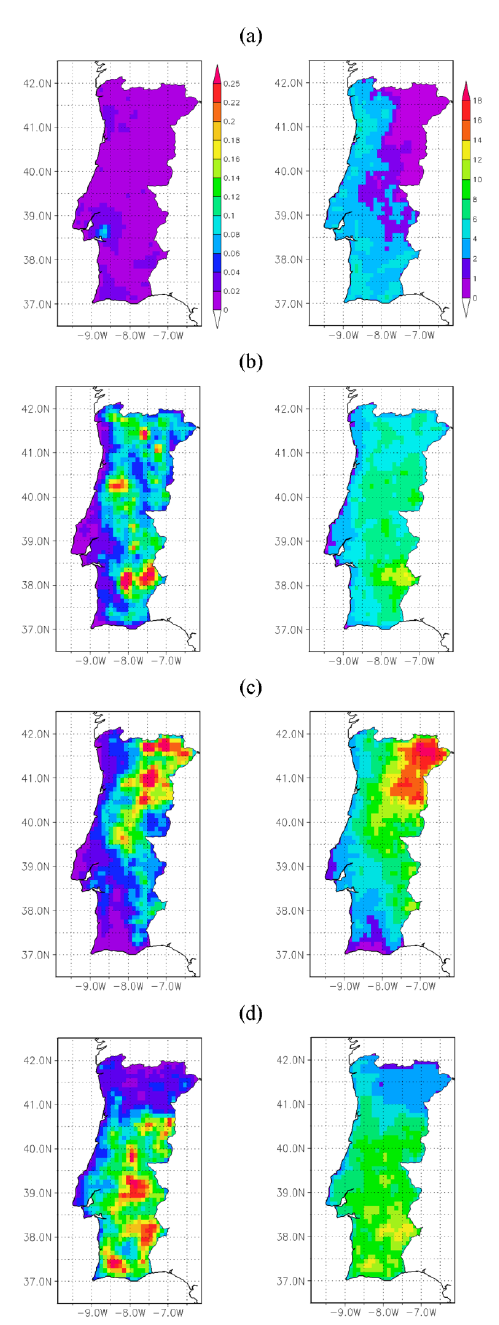
Figure 8. Maps of the KS mean total AEDCGD density ( left panels ; number of 681 Fig. 8. Maps of the KS mean total CGD density (left panels; num- ber of discharges.km − 2 .season − 1 ) and of the number of CGD days discharges.km -2 .season -1 ) and of the number of AEDCGD days recorded over Portugal 682 recorded over Portugal (right panels) for (a) DJF; (b) MAM; (c) JJA and (d) SON in 2003–2009. ( right panels ) for (a) DJF; (b) MAM; (c) JJA and (d) SON in 2003-2009. 683